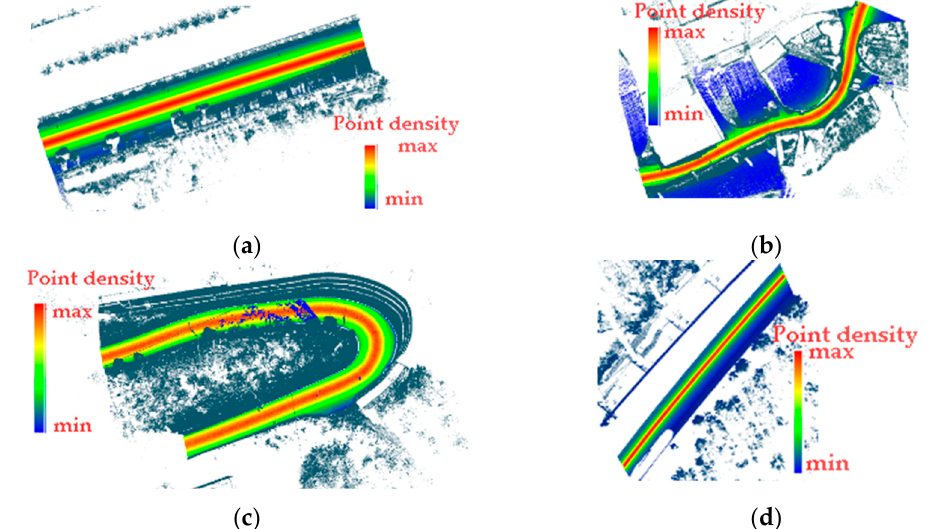
Figure 12. High-density area of the roads in four typical environments rendered with point density. ( a )